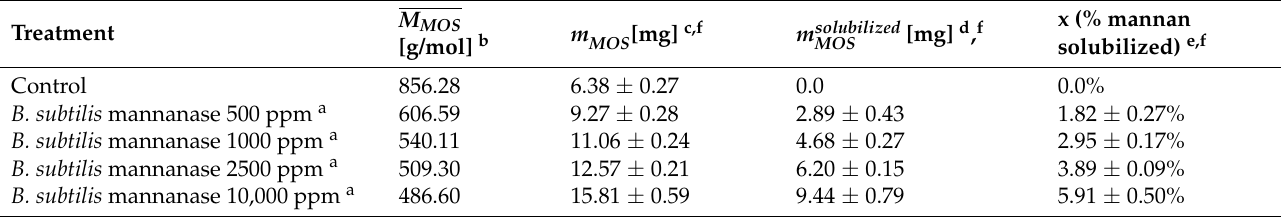
Table 3. Mannan solubilization by enzymatic treatment.